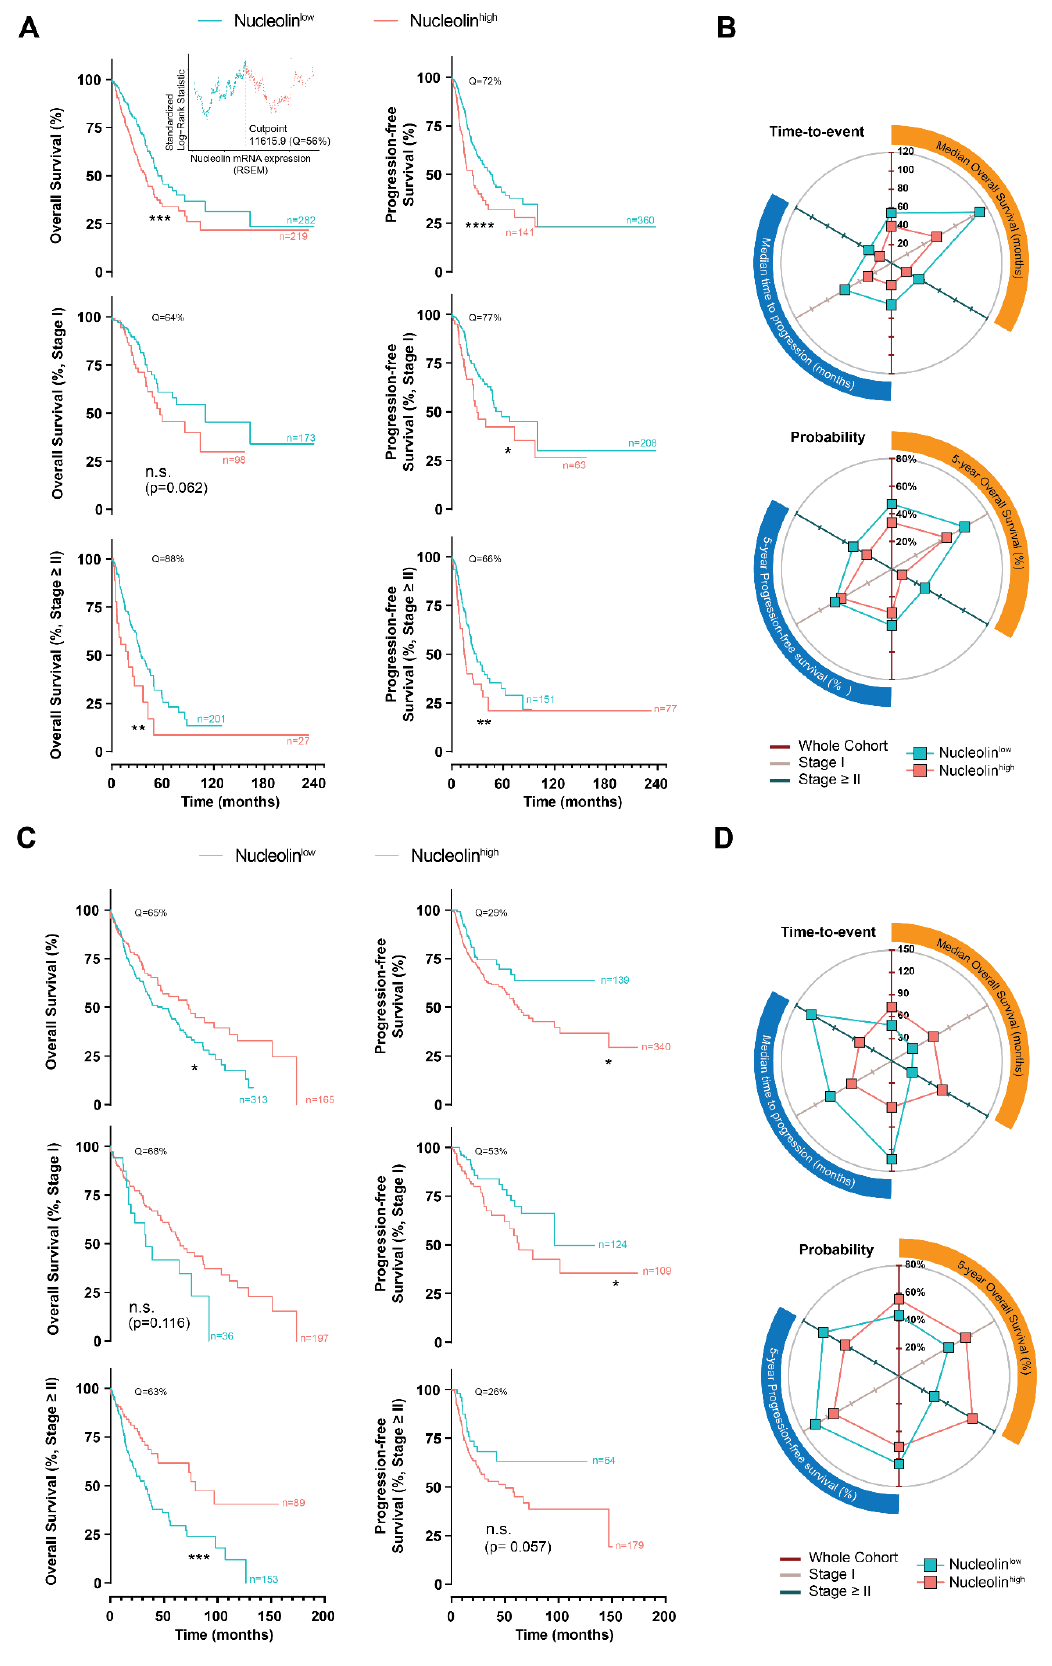
Figure 1. Epidemiological characterization of lung adenocarcinomas and squamous carcinomas as